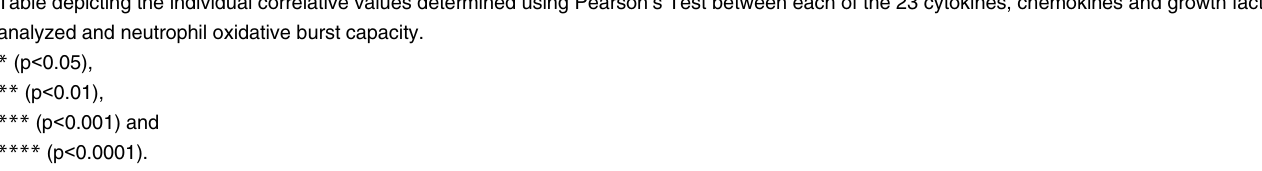
Table depicting the individual correlative values determined using Pearson ’ s Test between each of the 23 cytokines, chemokines and growth factors analyzed and neutrophil oxidative burst